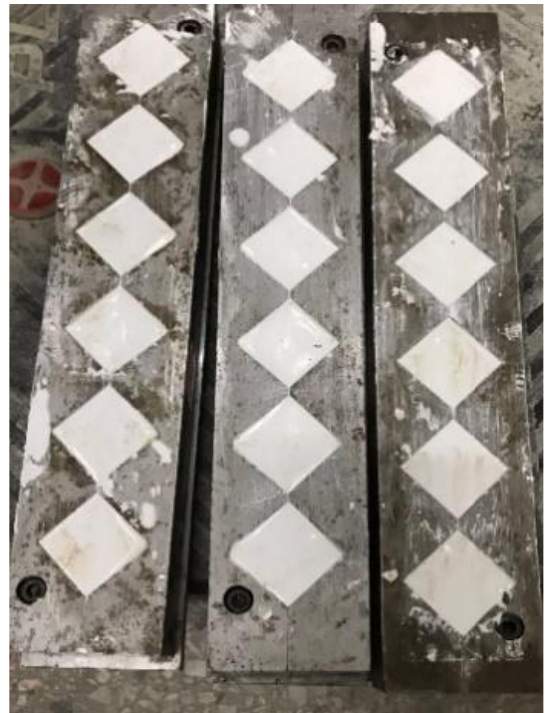
Figure 2. Test samples of the APC and anhydrite.